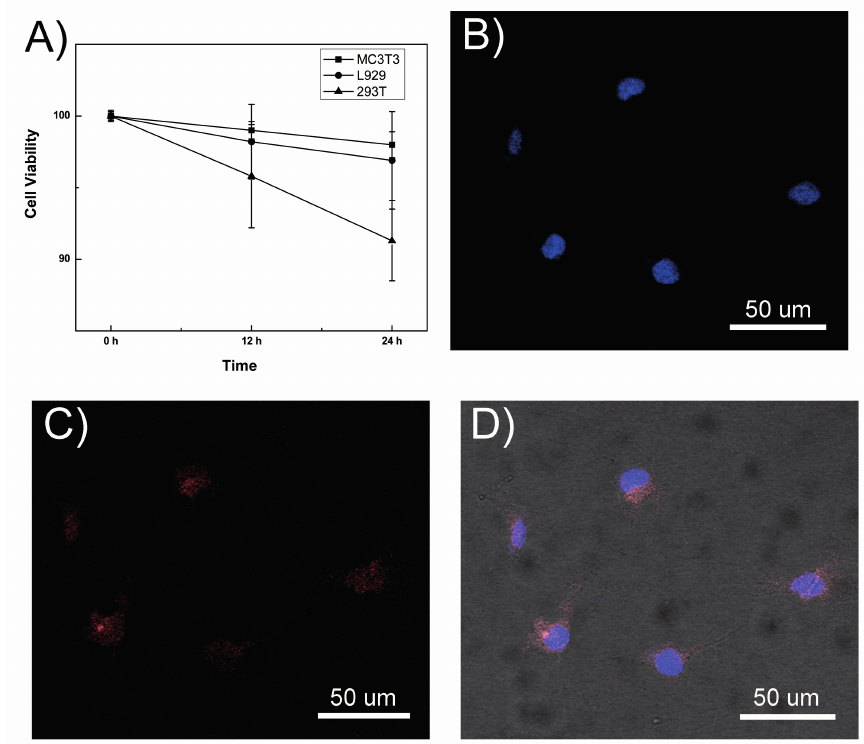
Figure 4. ( A ) Cell viabilities of mouse osteoblast precursor cell line MC3T3,